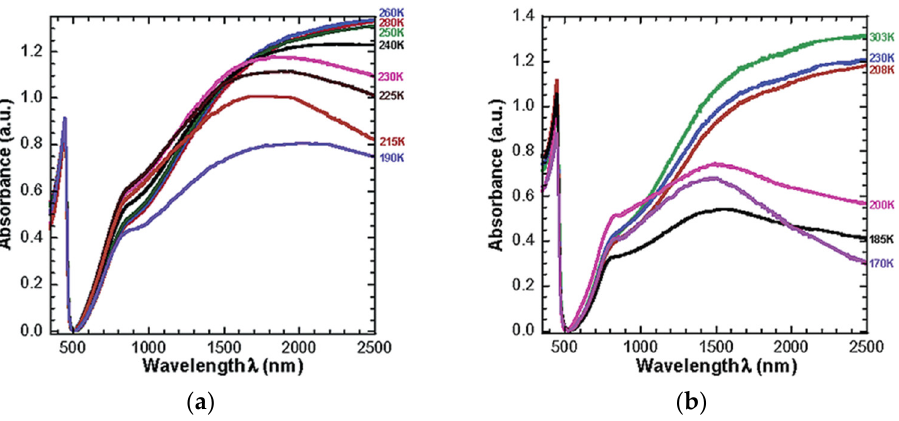
Figure 7. UV − vis − NIR spectra of ( a ) PANI(DBEEPSA)0.5 registered for the temperature range of 303 − 170 K (29.85 ◦ C–103.15 ◦ C). ( b ) PANI(DEHEPSA)0.5 registered for the temperature range of 280 − 190 K (6.85 ◦ C–83.15 ◦ C), Reproduced with the permission of Reference [8]. Copyright 2002 American Chemical